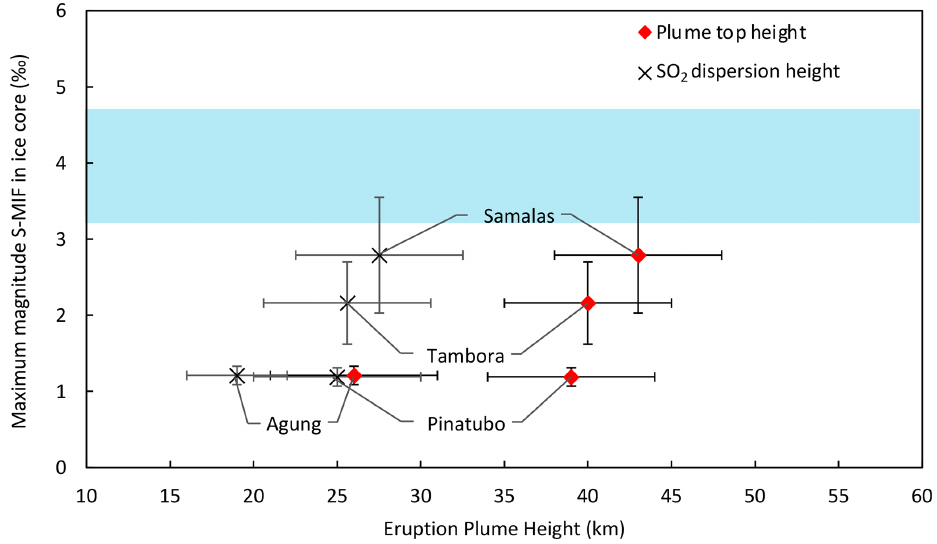
Figure 6. Maximum S-MIF signal ( (cid:49) 33 S) vs. both top plume height and SO 2 dispersion height for Common Era events. The highlighted box indicates the region of T1 and T2 MIF signals from this study. Height estimates are from Self and Rampino (2012) (Agung), Guo et al. (2004) and Holasek et al. (1996) (Pinatubo), Kandlbauer and Sparks (2014) (Tambora), and Vidal et al. (2016) (Samalas). Where available, we have used values for SO 2 dispersion height from the literature, otherwise we have used the ratio of SO 2 dispersion height to plume top of the Pinatubo 1991CE eruption as a multiplier, a value of 0.64. (cid:49) 33 S data are from Baroni et al. (2007) (Pinatubo, Agung) and Burke et al. (2019) (Tambora,